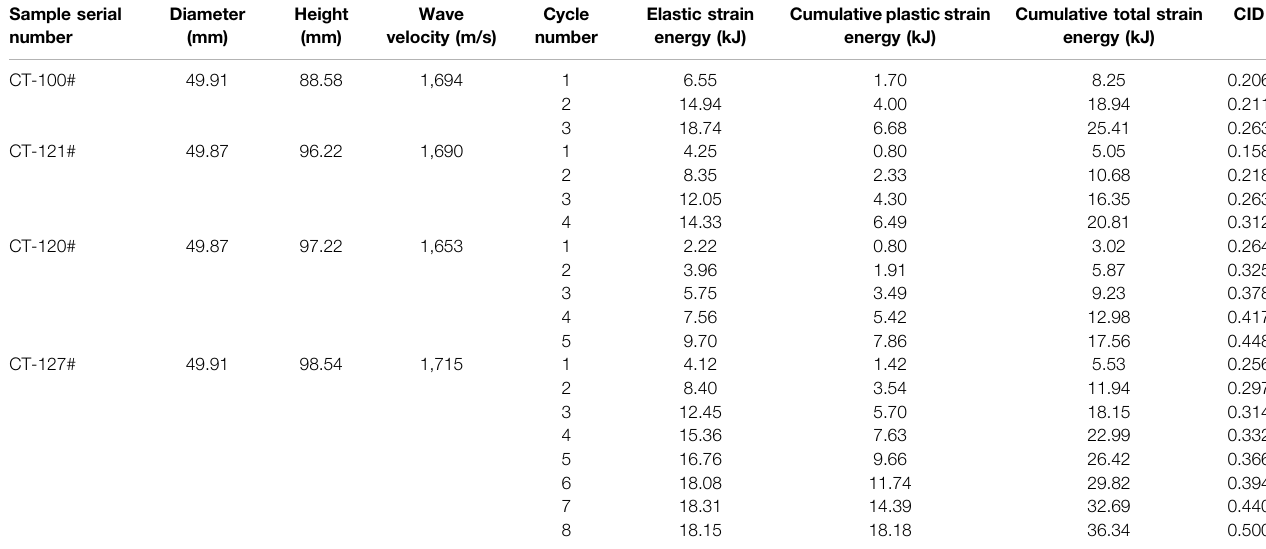
TABLE 2 | CID calculation of coal samples. Sample serial